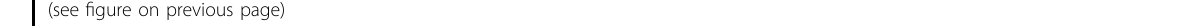
Fig. 2 Beraprost promotes the regeneration of bone defects. A Representative images of micro-CT reconstruction of femoral cortical bone defects. B – D Histomorphometric analysis of the regenerated bone. The mean values of the bilateral defects of each mouse were counted as individual data points. Results are shown as mean ± SD; n = 5; ** P < 0.01, *** P < 0.001 by ANOVA with Tukey ’ s post-hoc test. E – H Quantitative analyses of micro-CT of distal femurs. Results are shown as mean ± SD; n = 5; ** P < 0.01, *** P < 0.001 by ANOVA with Tukey ’ s post-hoc test. I , J Serum concentration of β -CTX and P1NP. Results are shown as mean ± SD; n = 5; * P < 0.05, *** P < 0.001 by ANOVA with Tukey ’ s post-hoc test. K H&E staining of femoral bone defects. L Representative images of immunohistochemical staining of Runx2. Scale bar, 20 µm. M , N Representative images of ALP and TRAP staining. Scale bar, 20 µm. O , P Quanti fi cation of Alp and TRAP staining. Results are shown as mean ± SD; n = 5, * P < 0.05, ** P < 0.01 by ANOVA with Tukey ’ s post-hoc test.